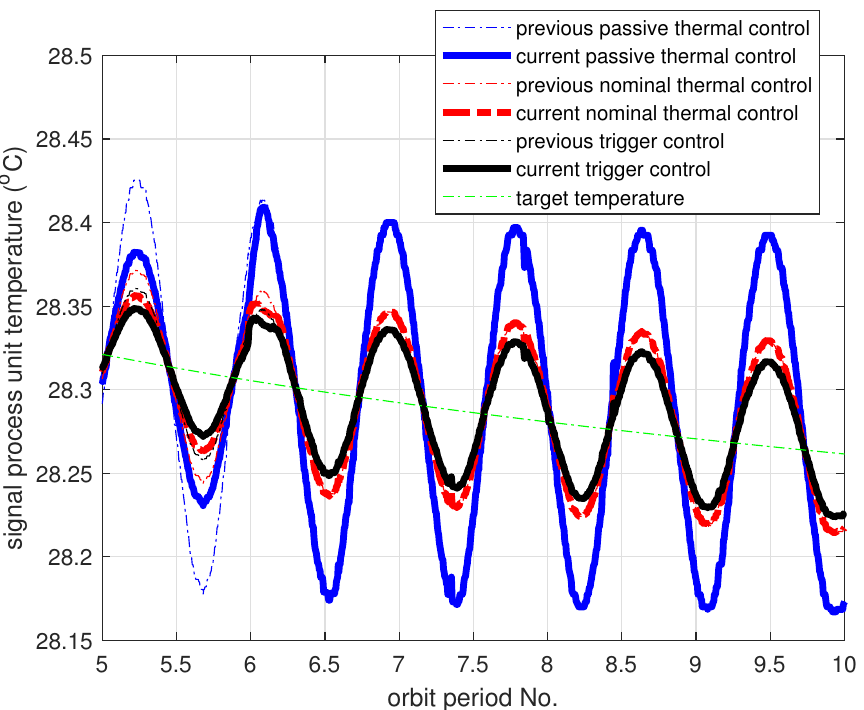
Figure 8. Comparison of different thermal control algorithms with learning processes for the signal process